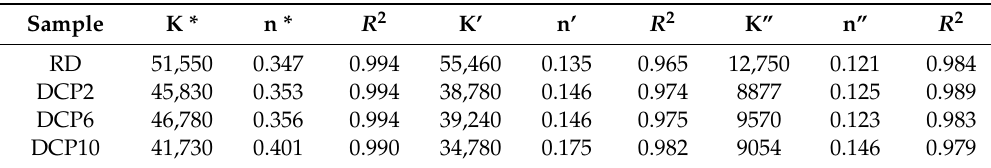
Table 1. The viscoelastic properties of